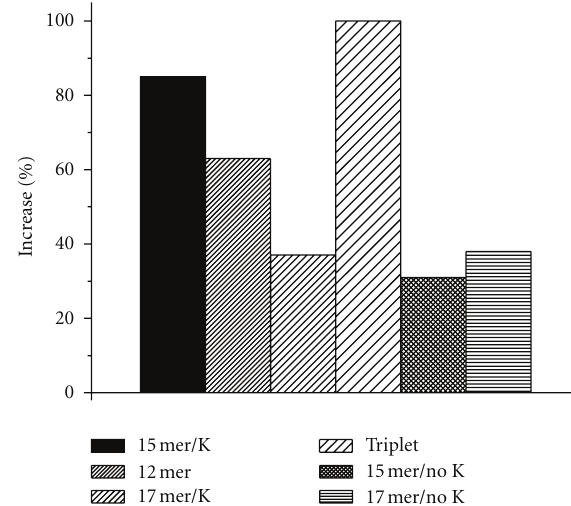
Figure 1: Percentage increase ( ± 4%) in PRLS intensity of gold nanoparticles at 540 nm upon addition of 2.1nM DNA. Samples were annealed in presence of